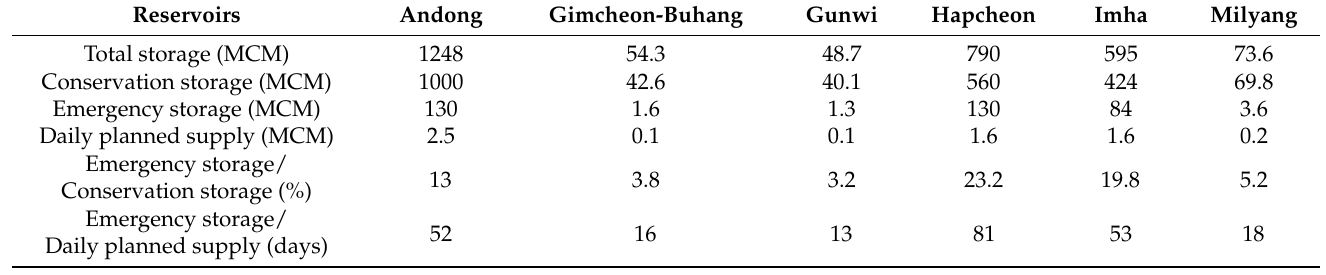
Table 2. Characteristics of six multipurpose reservoirs in the Nakdong River Basin.